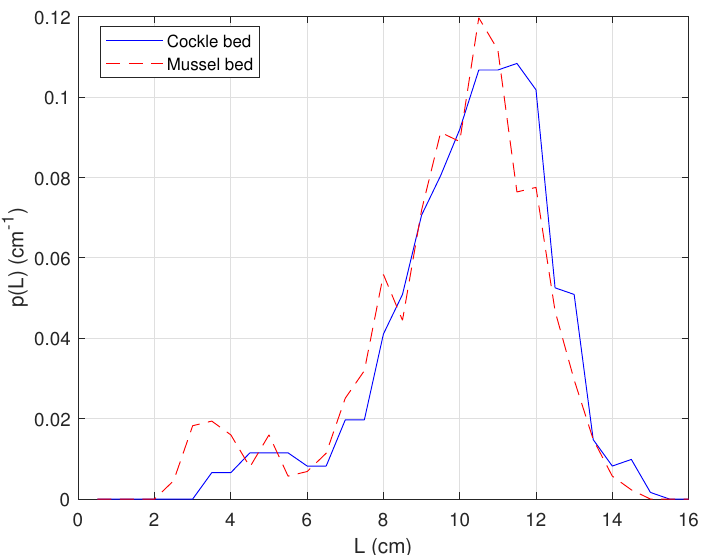
Figure 3. Probability density functions based on 609 individuals sampled on cockle beds and 877 on mussel beds (group